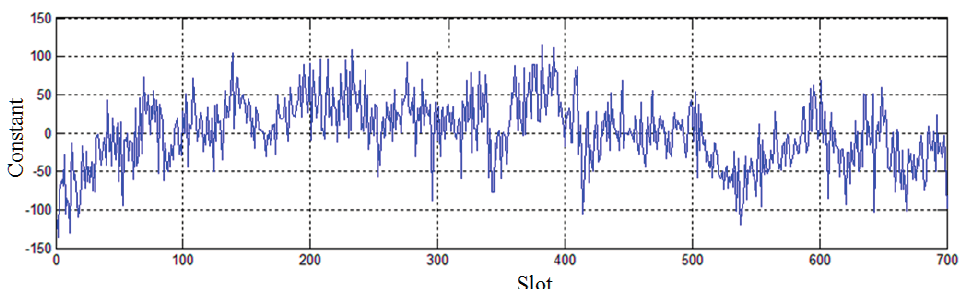
Figure 6. Experimental results after the linear fitting based on the least squares